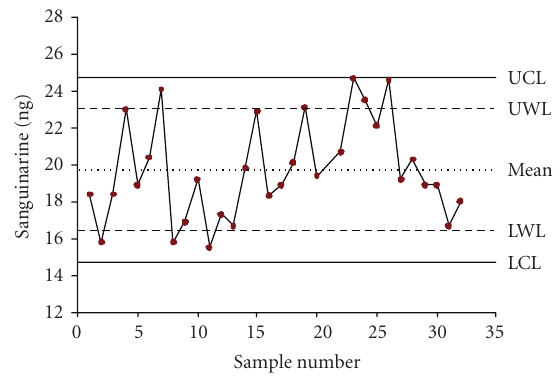
Figure 3: Shewhart chart for control of the chromatographic anal- ysis of sanguinarine. UCL and LCL: upper and lower control limits. UWL and LWL: upper and lower warning limits. Mean = 19 . 72, S = 1 . 66.